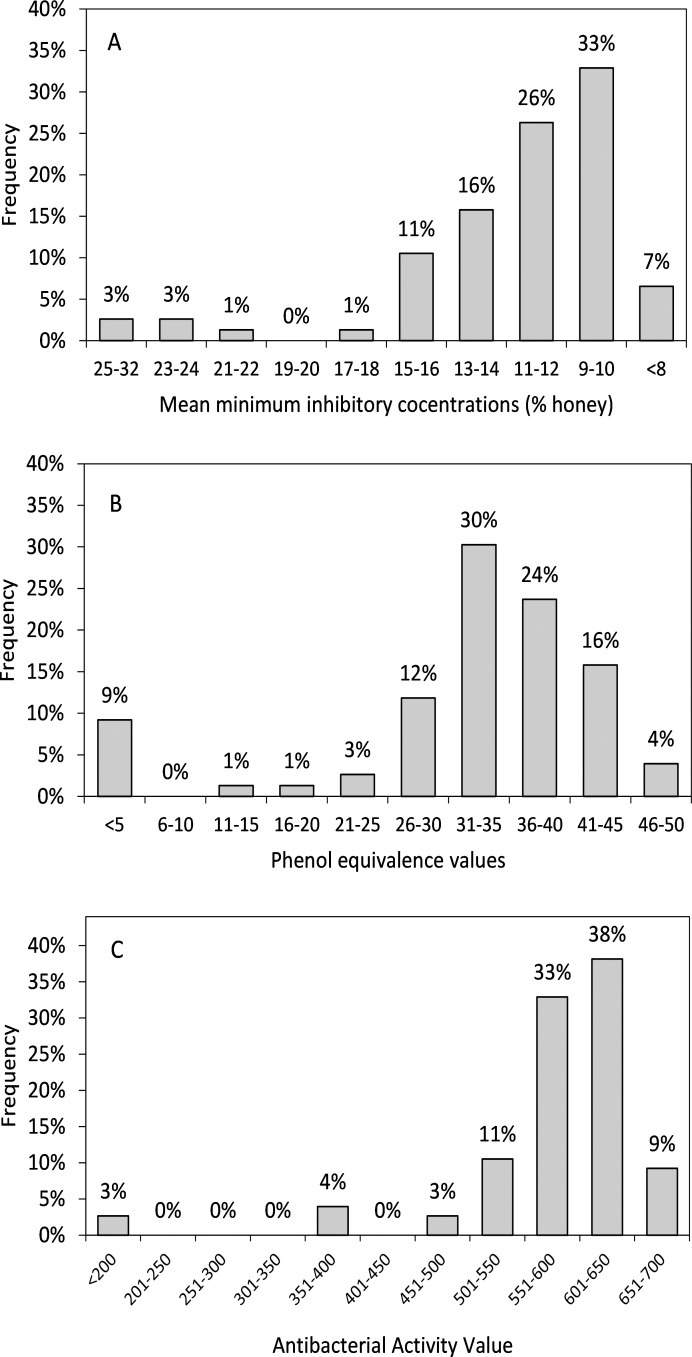
Distribution of antibacterial activity values obtained for 77 honeys using three testing methods.(A) Mean minimum inhibitory concentrations (% w/v) obtained by broth microdilution using Staphylococcus aureus ATCC 29213, Enterococcus faecalis ATCC 29212, Escherichia coli ATCC 25922 and Pseudomonas aeruginosa ATCC 27853. (B) PE values determined using Staphylococcus aureus ATCC 25923. (C) New assay activity units, determined from relative growth of S. aureus ATCC 29213, E. faecalis ATCC 29212, E. coli ATCC 25922 and P. aeruginosa ATCC 27853 cultured with six different concentrations of honey. Each measurand was grouped into categories for the purpose of plotting the histograms.